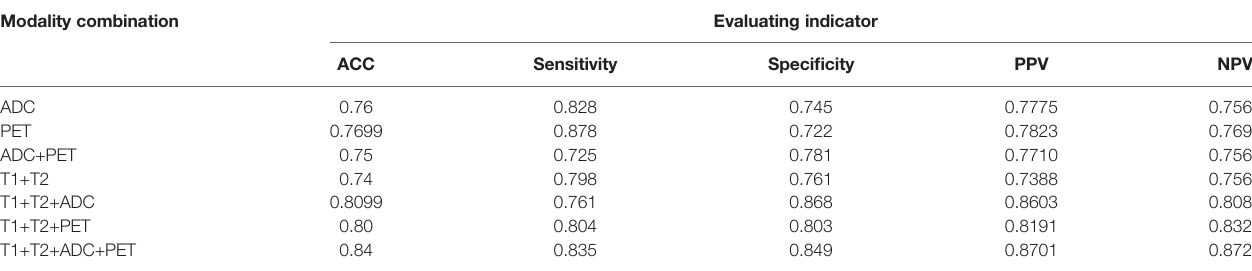
TABLE 4 | Comparison of more evaluation indicator information. Modality combination Evaluating